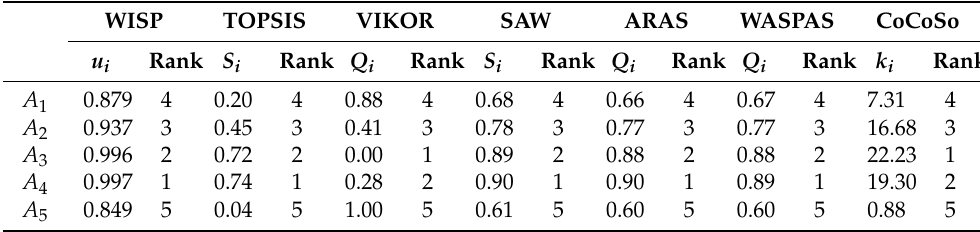
Table 21. Ranking results obtained using selected MCDM methods.